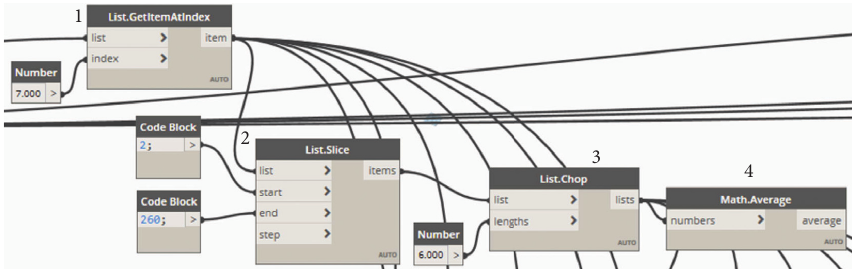
Figure 10: Selection and average of the lists of measurement for the association to the model parameters.